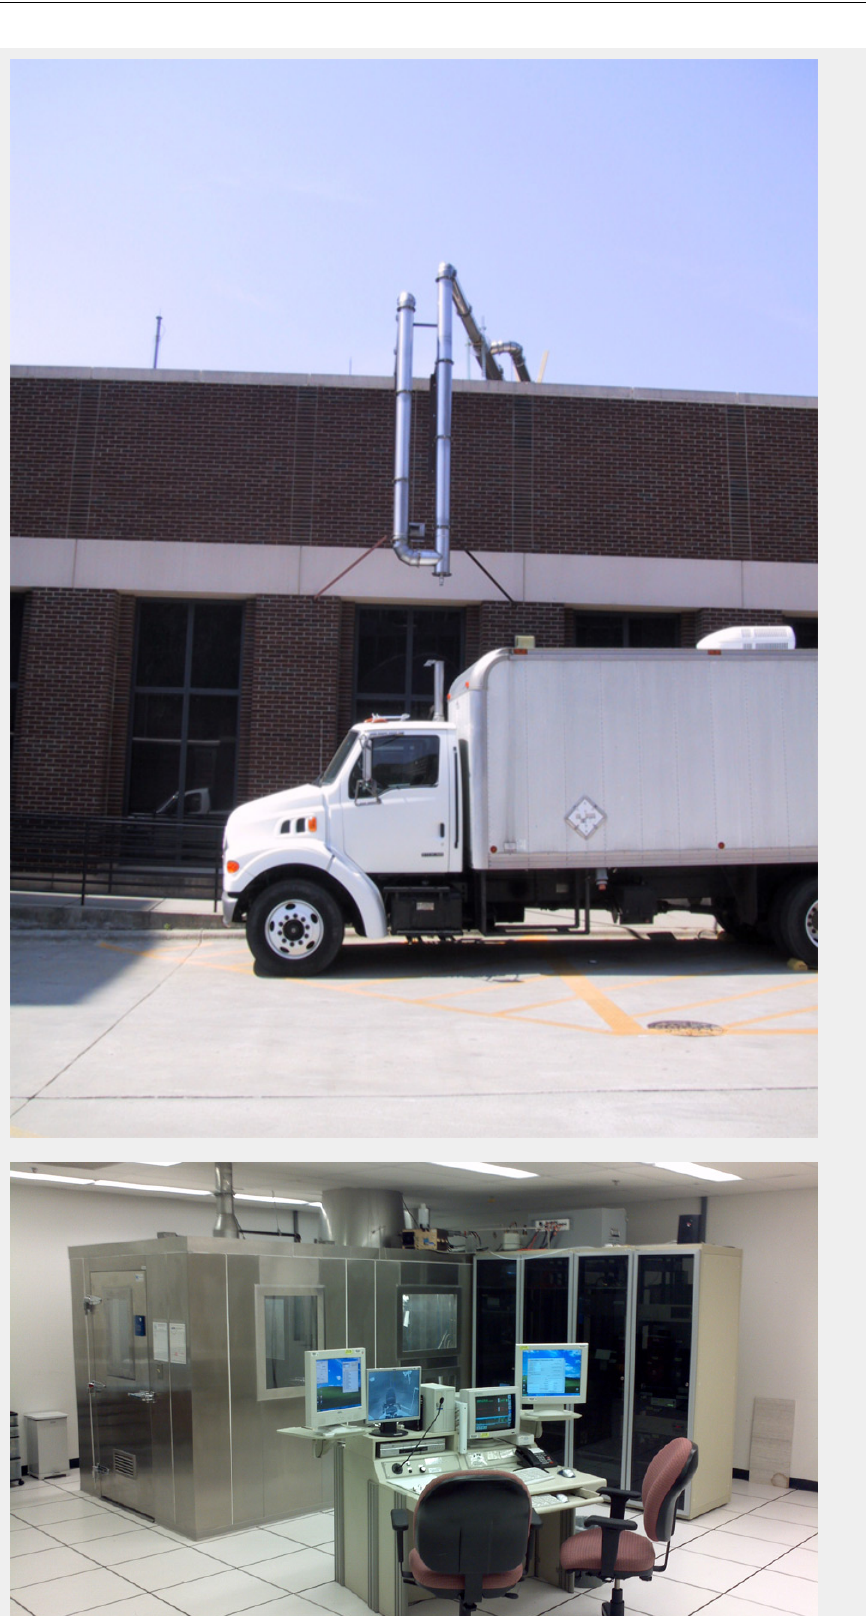
Diesel exhaust is collected from an idling truck parked outside the building (A). This is diluted with filtered air and introduced through piping (arrow) into an exposure chamber